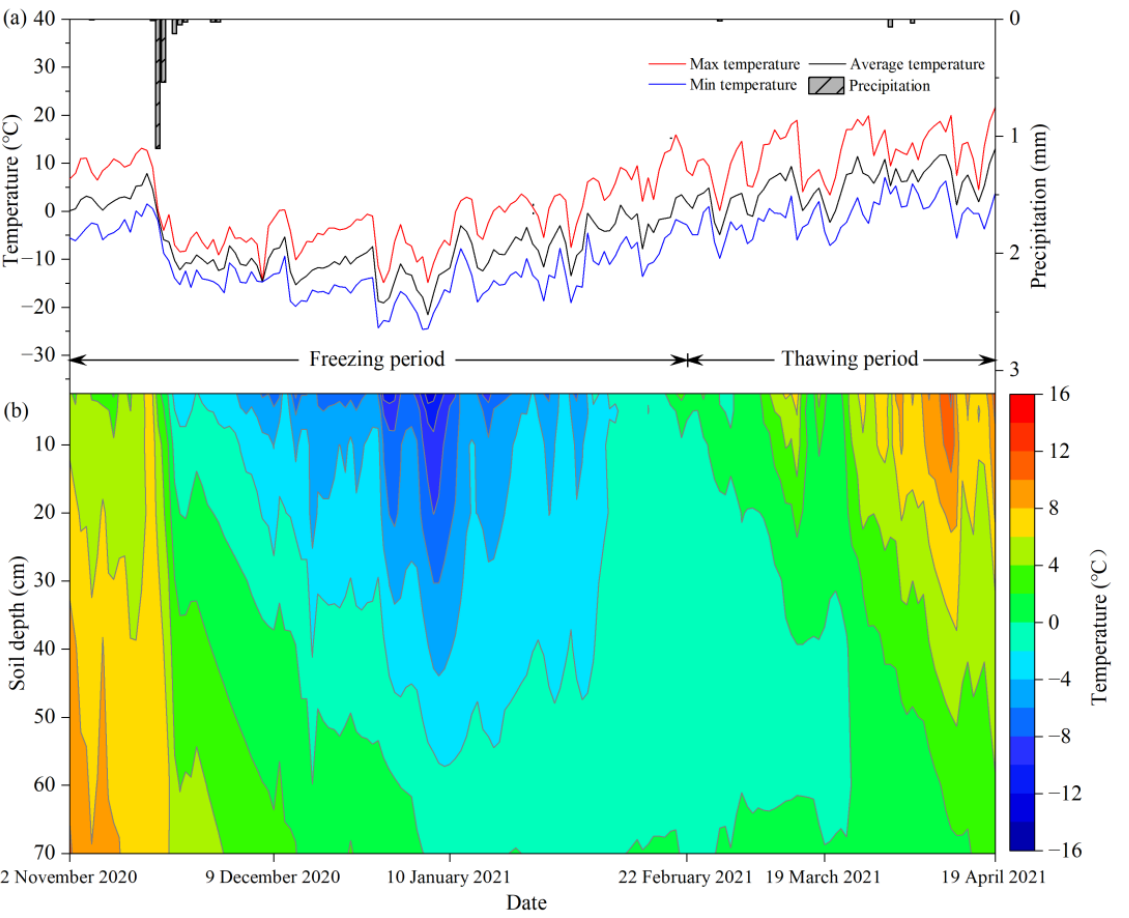
Figure 2. Variations in precipitation and air temperature ( a ), and soil temperature ( b ) during the freeze – thaw process.